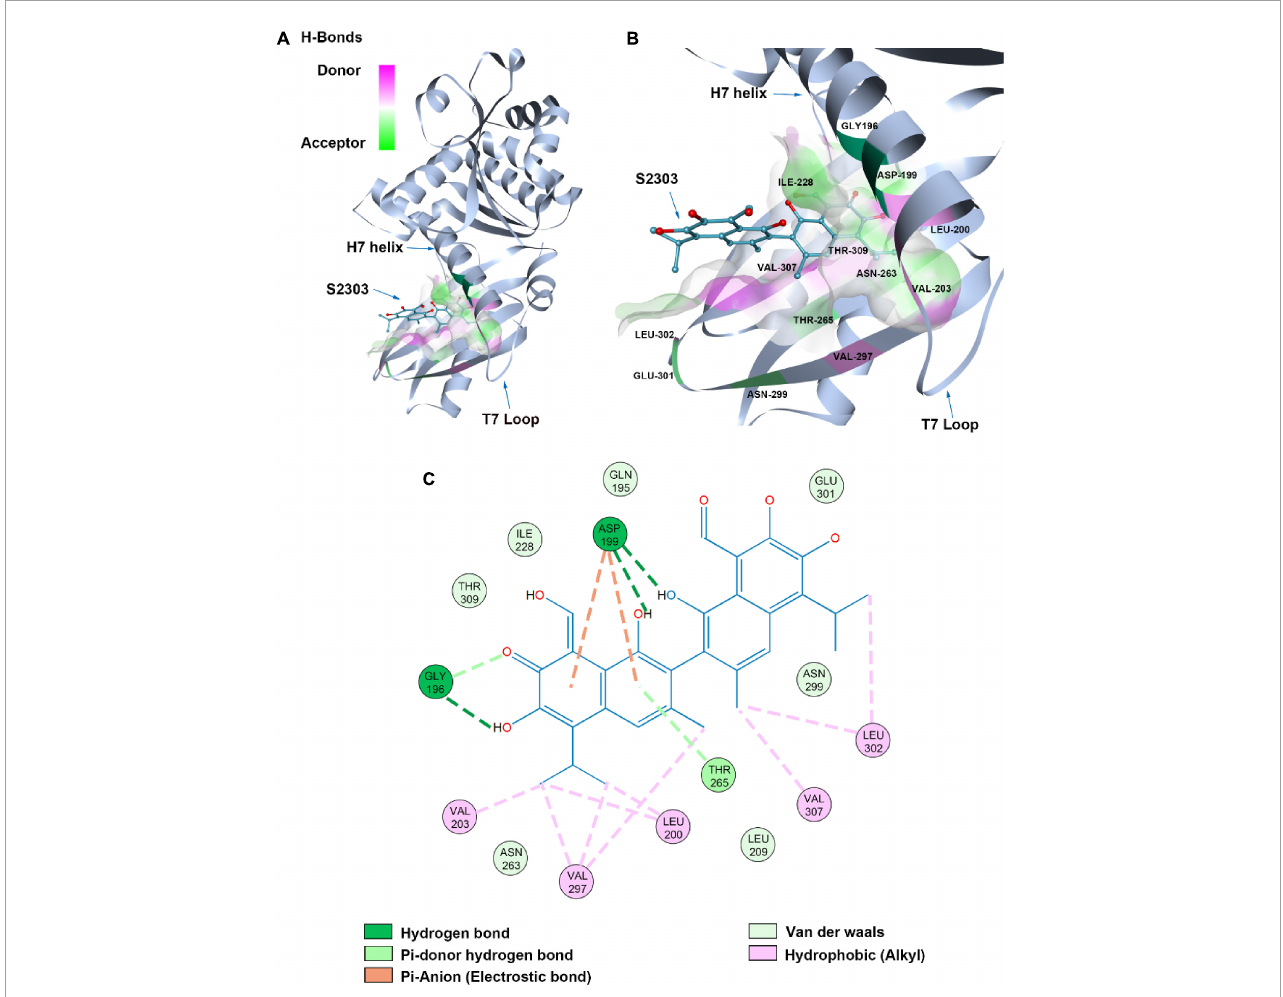
FIGURE11 Proposed binding mode of S2303 in Staphylococcus aureus FtsZ (PDB code: 4DXD) analyzed by Discovery Studio (DS). The panel (A) shows the whole structure of FtsZ, and the binding pose of S2303 in the pocket while the panel (B) shows the enlarged hot spot, where we can see the amino acids which proposed have interactions with S2303. The 2D interaction diagram of S2303 with amino acids involved in the hot spot (PC190723 binding site in FtsZ) is shown in the panel (C) . The transparent interaction surface of FtsZ with S2303 is colored by hydrogen bond donor (red) or acceptor (green). Key amino acids estimated to participate in the interactions between S2303 and FtsZ on a 2D diagram are shown and